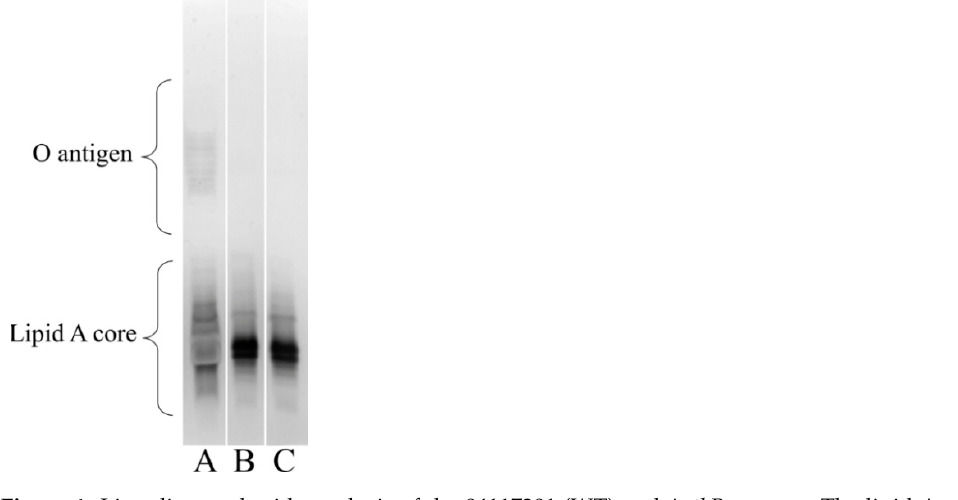
Figure 4. Lipooligosaccharide analysis of the 04117201 (WT) and Δ stkR mutant. The lipid A and O-antigen components of the strains’ membrane was resolved on a 15% polyacrylamide gel and silver stained. ( A ) control lipopolysaccharide from Pseudomonas aeruginosa PA01 showing the presence of O-antigen; ( B ) WT, and ( C ) Δ stkR . Brackets identify either the lipid A core or O-antigen regions.